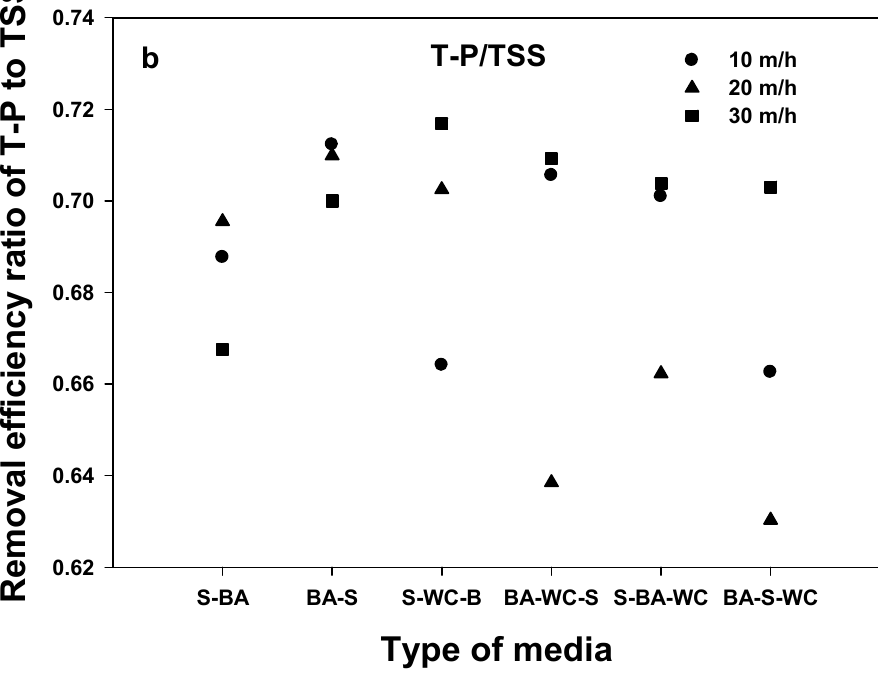
Figure 7. Removal efficiency ratios of T-N to TSS ( a ) and T-P to TSS ( b ) for six media types and three different HCs (10, 20, and 30 m/h).